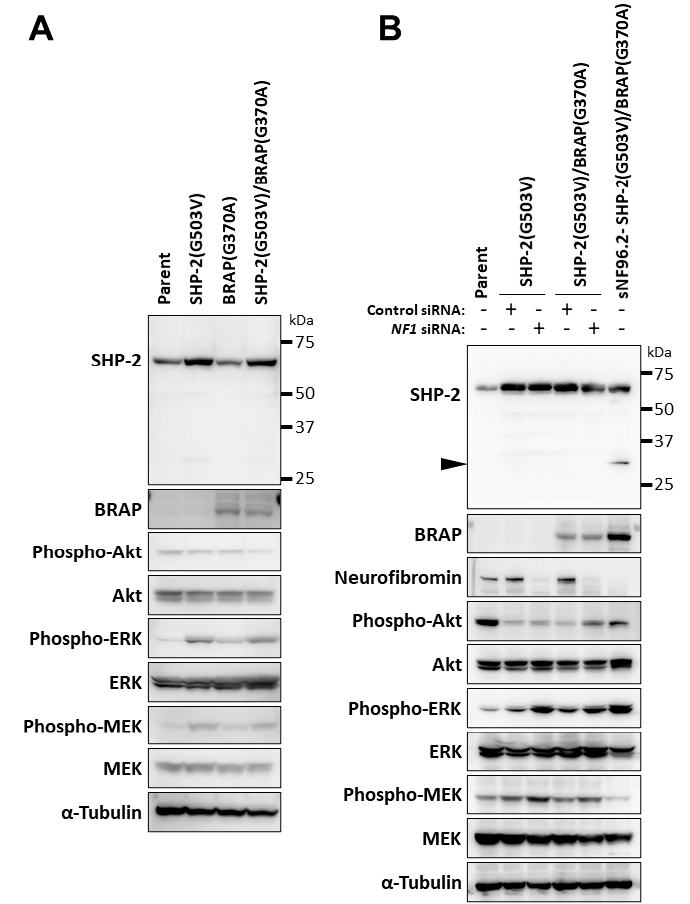
Figure 6. Relation of phenotypes induced by BRAP and PTPN11 missense mutations to NF1 inactivation. Immunoblot analysis was performed for SHP-2, BRAP, neurofibromin, as well as phosphorylated and total forms of Akt, ERK, and MEK in parental HeLa cells as well as HeLa cells transiently expressing SHP-2 (G503V) or BRAP (G370A). The uncropped western blot figures are shown in Figure S5. ( A ) or in the corresponding stably infected cells transfected with control or NF1 siRNAs for 48 h ( B ). sNF96.2-GFP cells expressing SHP-2 (G503V) and BRAP (G370A) are shown for comparison to indicate the cleavage product of SHP-2 (arrowhead). The uncropped western blot figures are shown in Figure